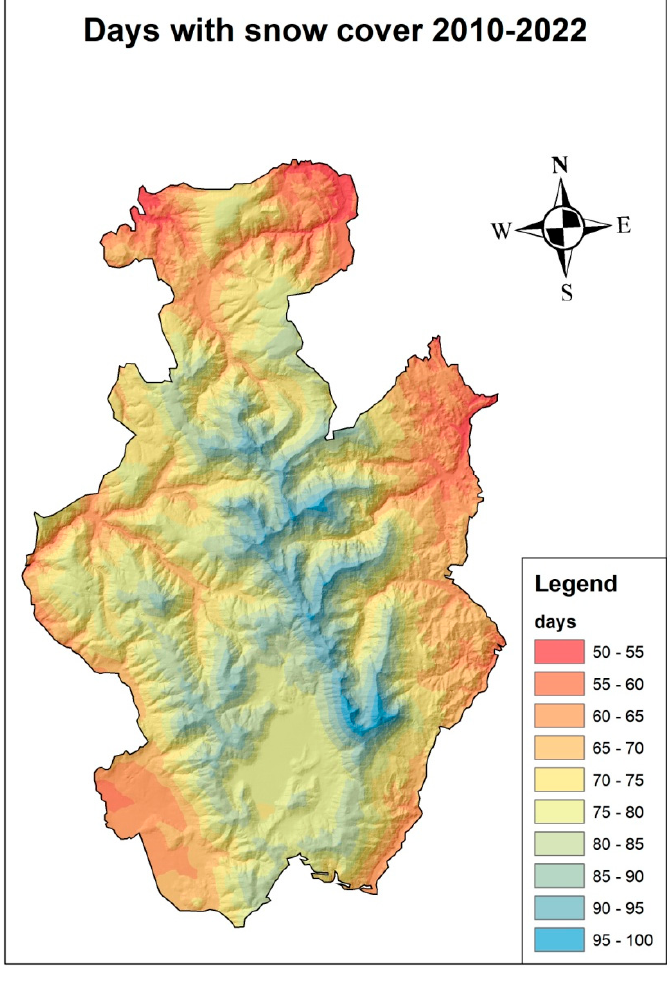
Figure 8. Days with snow cover in the period 2010–2022 measured in cm.